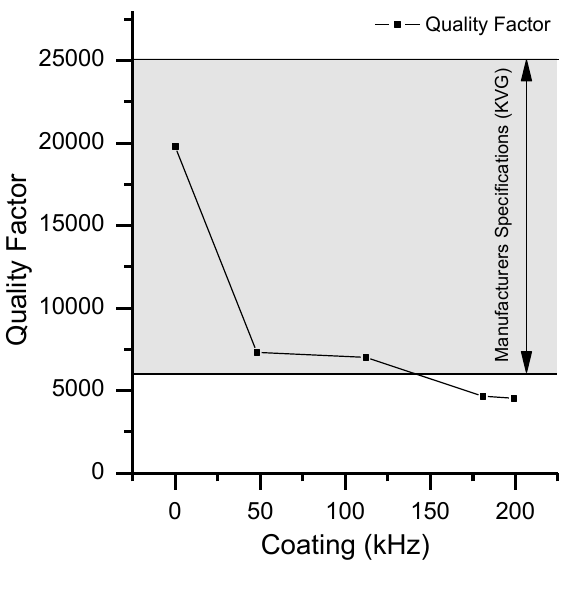
Figure 4. Decay of the Q-factor of a resonator with increasing coating